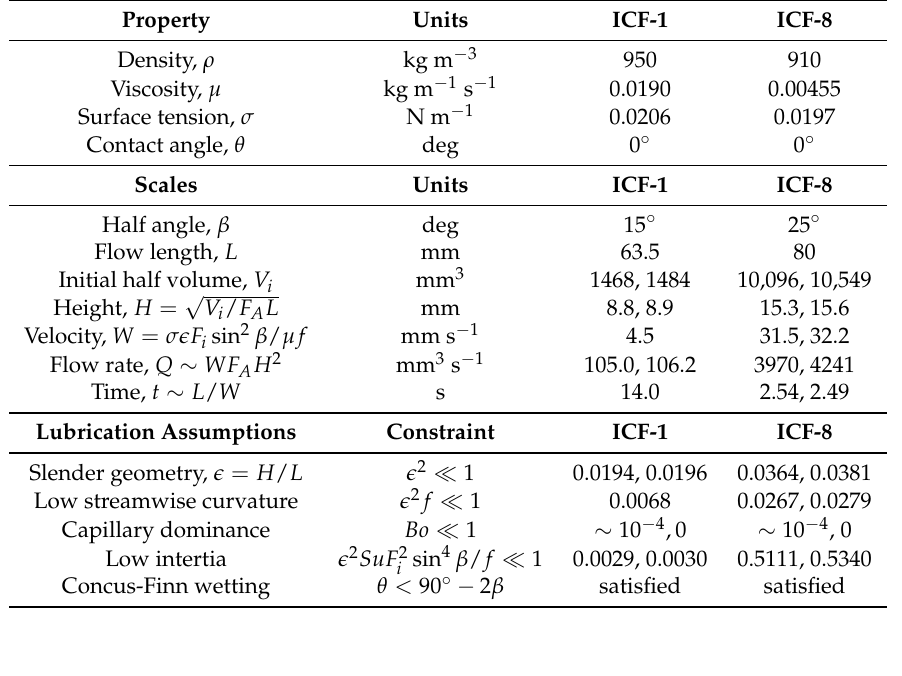
Table 1. ICF-1 fluid properties, scales, and constraints. Dual values listed as (experiment, simulation) when different from each other.